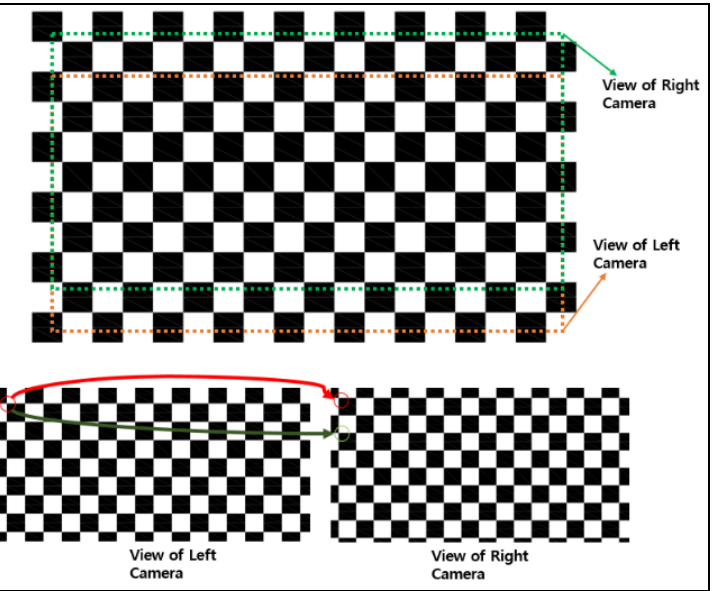
Figure 3. Rectification error caused by a problem during the assembly process of the camera.